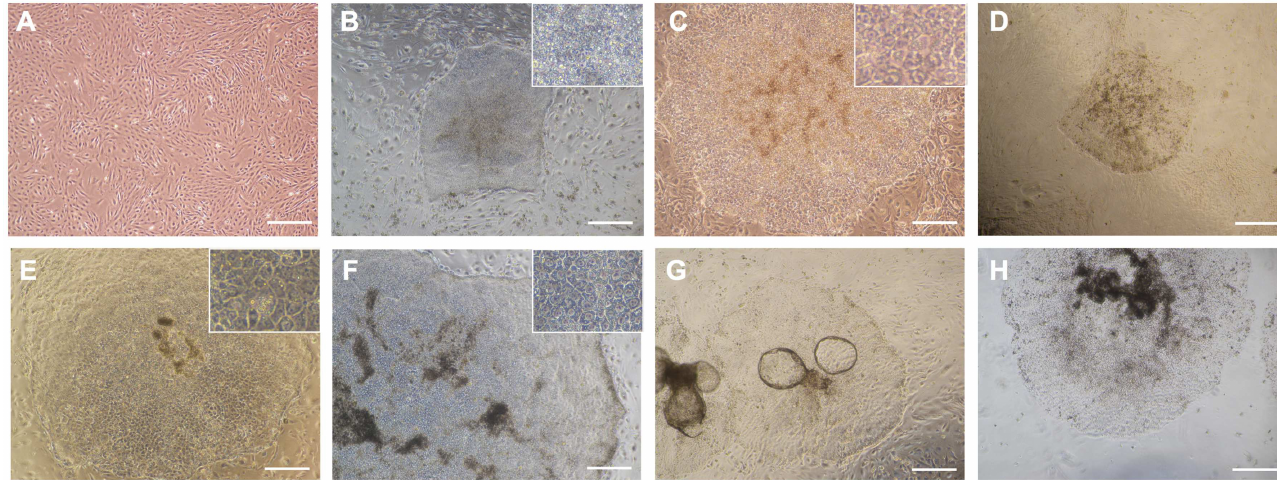
Fig 2. Phase-contrast images of bovine-induced trophoblastic cells (biTBCs). (A) Bovine amniotic cells (bADCs). (B) iPSC-like colonies appearingin the culture medium used for human iPSCs. (C) Trophoblast-like coloniesappearingin the culture medium used for humaniPSCs. (D) Primary trophoblast-like coloniesappearingin the trophoblastcell medium at day 14. (E) Established biTBCs derived from bADCs. (F) Established biTBCs derived from bovine fetal liver cells (bFLCs). (G) Formation of trophoblastic vesicles(TVs) in central areas of coloniesduringculture. (H) Established biTBCs cultured on collagen-coated dishes. (A)-(H) scale bars = 500 μ